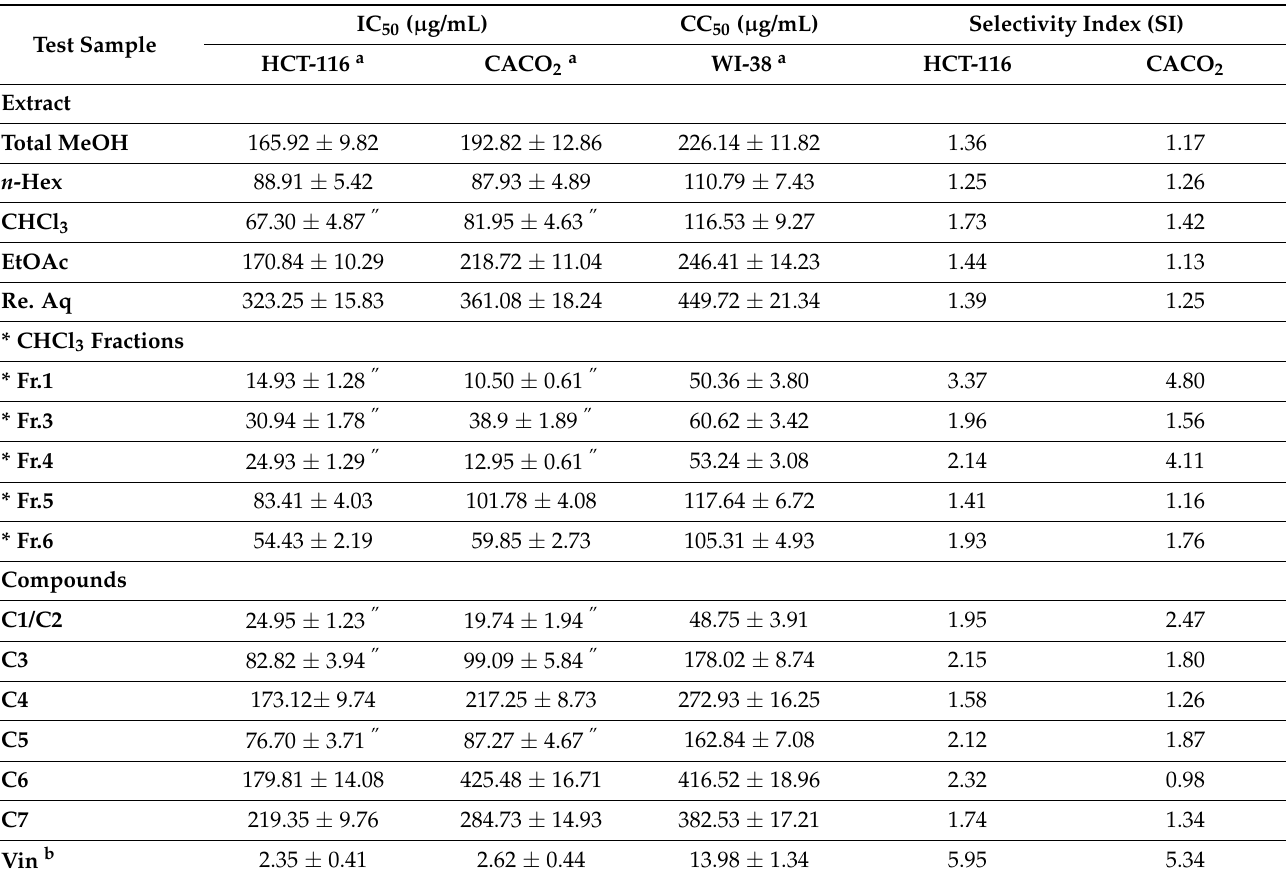
Table 3. In vitro cytotoxic activity (IC 50 , µ g/mL), selectivity index (SI) of the different extracts, fractions, and compounds C1 – C7 from E. erinaceus